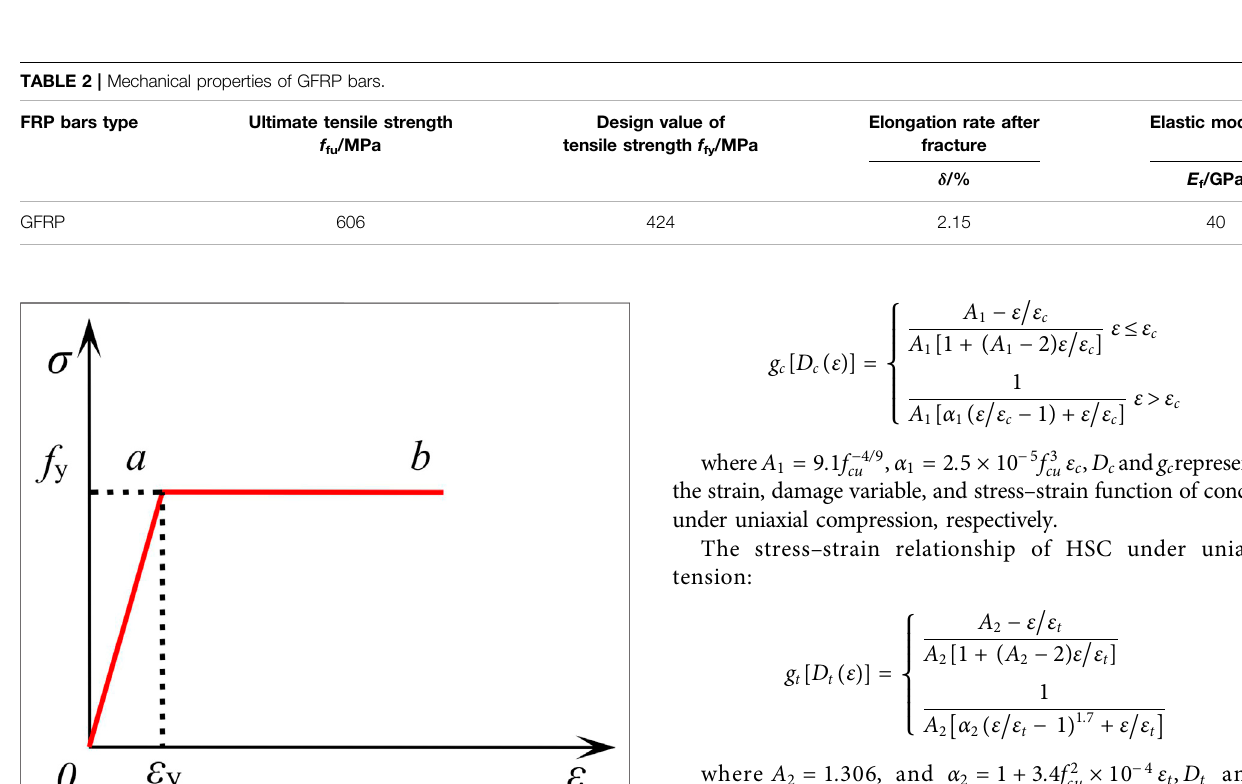
FIGURE 2 | Constitutive model of GFRP bars.